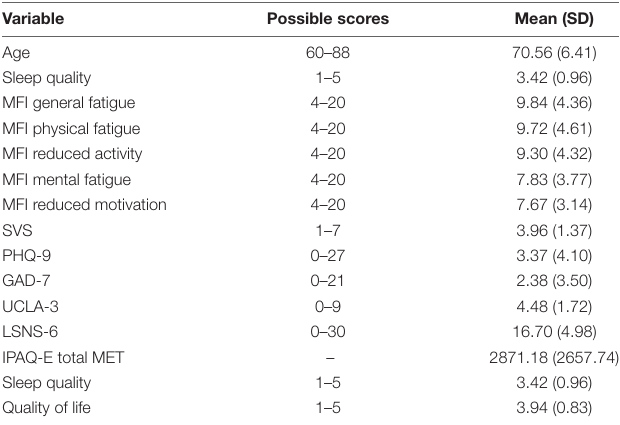
TABLE 3 | Descriptive statistics for variables.